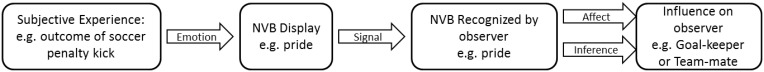
Hypothesized model based on Van Kleef (2009) on the display of emotional nonverbal expressions in a sports situation.